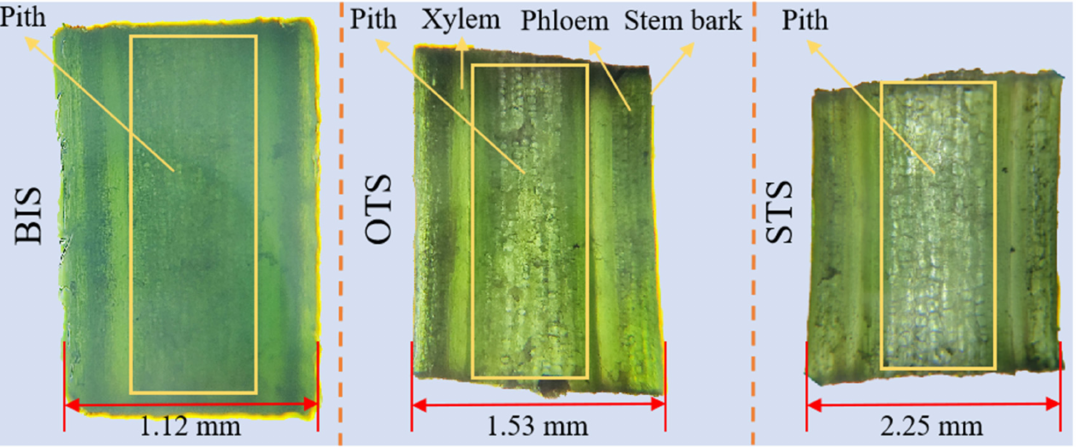
Figure 11. Longitudinal micro-sectional view of different parts of tea stalks. BIS: stalks between buds and leaves; OTS: one and two leaves interstitial stalks; STS: stalks between second and third